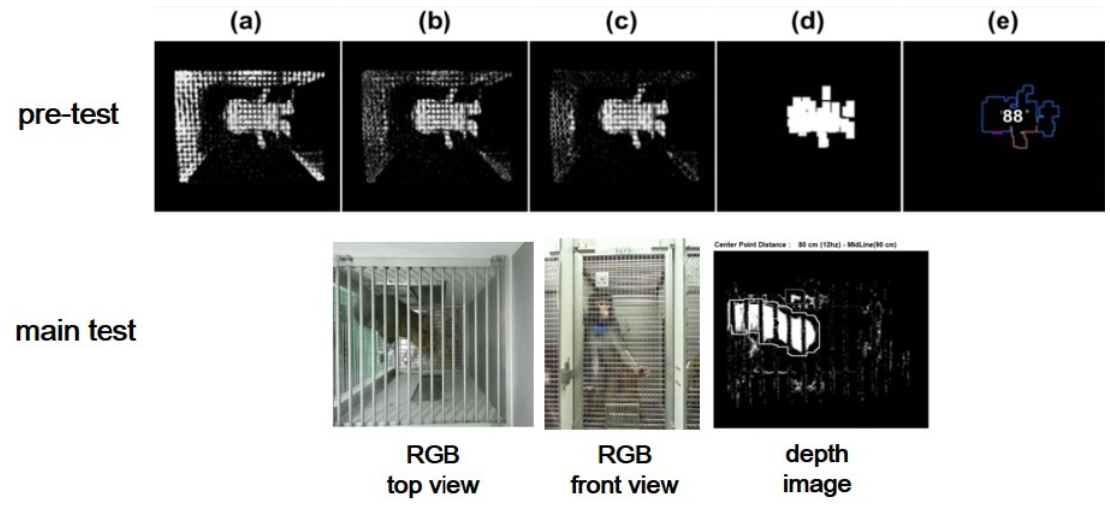
Figure 3. Automated program process for pre-test: ( a – d ) background reduction and noise elimination, ( e ) centroid, centroid area and measuring point identification. RGB and depth images from main test.